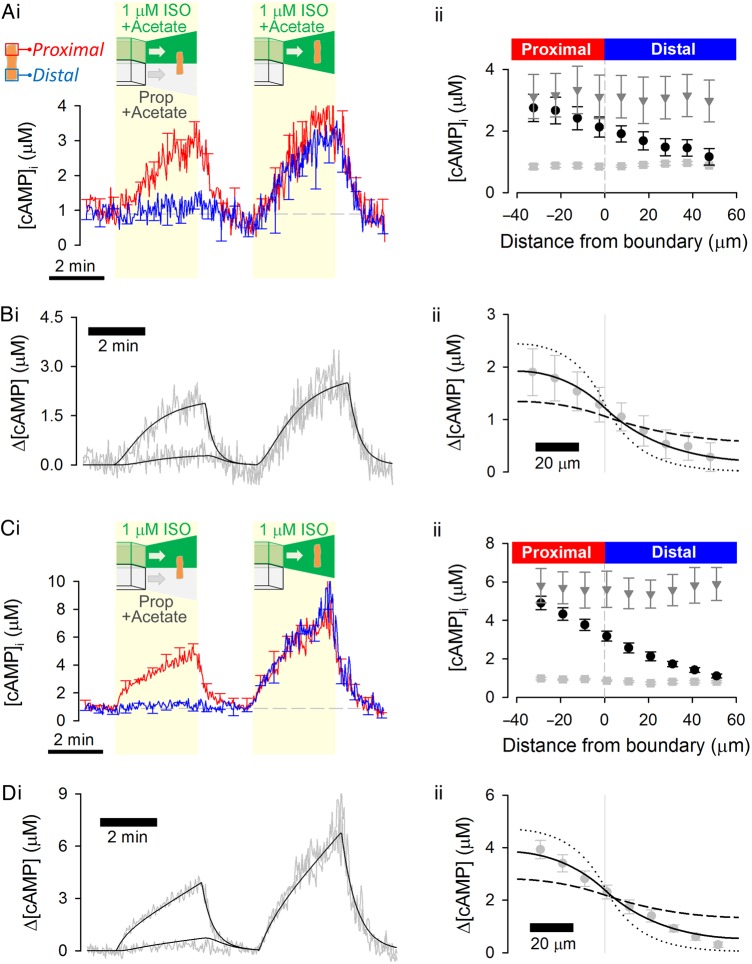
Cytoplasmic cAMP diffusivity is not changed by cytoplasmic acidification. (A) Experiment similar to that shown in Figure 1B repeated on myocytes exposed to 80 mM acetate to acidify cytoplasm uniformly (n = 7/3). 5-(N,N)-dimethylamiloride (DMA; 30 µM) was included in both microstreams to inhibit pH regulation by Na+/H+ exchanger 1. (B) Model fit to experimental data, with best-fit DcAMP = 41 ± 12.2 µm2/s confirming slow diffusivity. (C) Experiment shown in Figure 4A repeated, but with acetate in the distal microstream only; DMA (30 µM) was included in both microstreams (n = 6/3). This protocol produces a pH-gradient overlying the gradient of β-adrenoceptor activation; higher pH in ISO-containing microstream favours greater cAMP production. (D) Model fit to experimental data with best-fit DcAMP = 32 ± 4.8 µm2/s confirming slow diffusivity. To illustrate the goodness-of-fit data, longitudinal profiles in Bii and Dii were also simulated for a four-fold lower (dotted lines) and a four-fold higher (dashed lines) DcAMP.